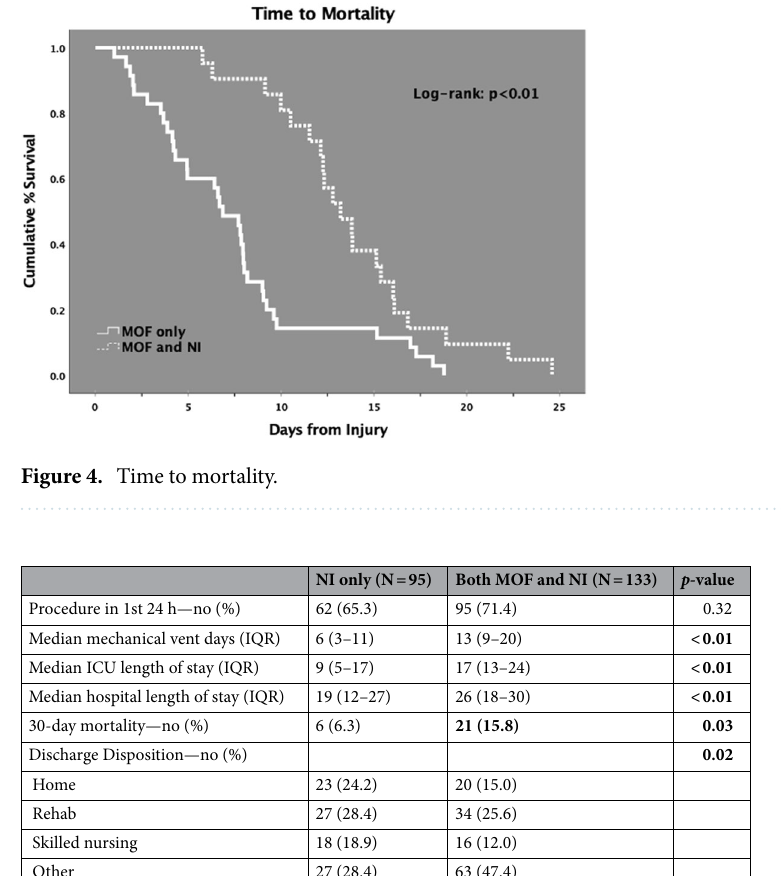
Table 4. Hospital resource utilization individually attributable to MOF versus NI. Significant values are in bold.